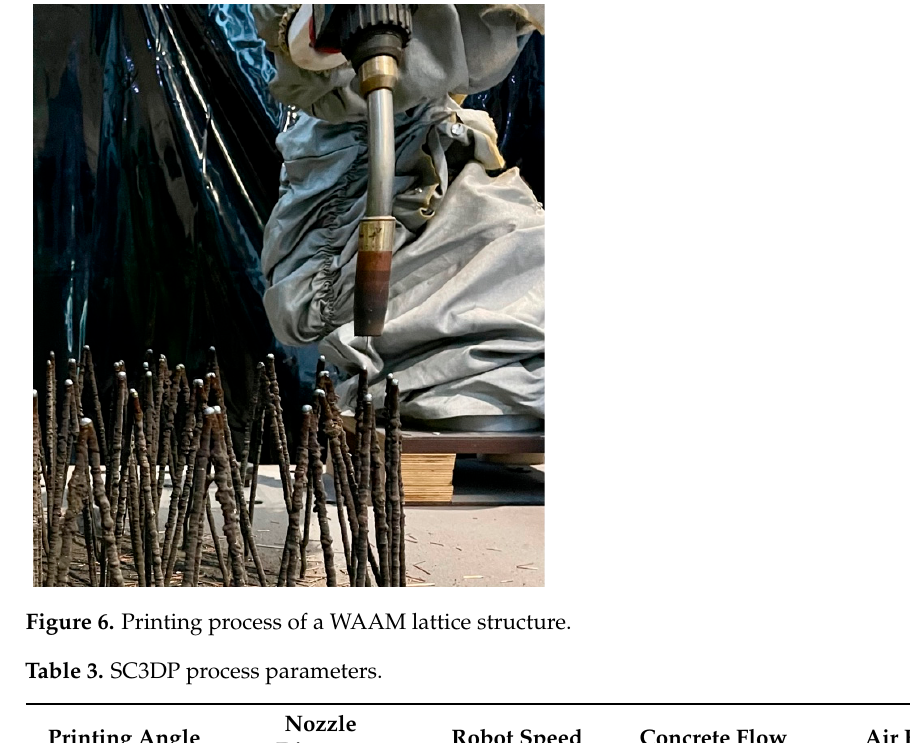
8 of 11 Table 2. Constant welding, motion and geometric parameters.